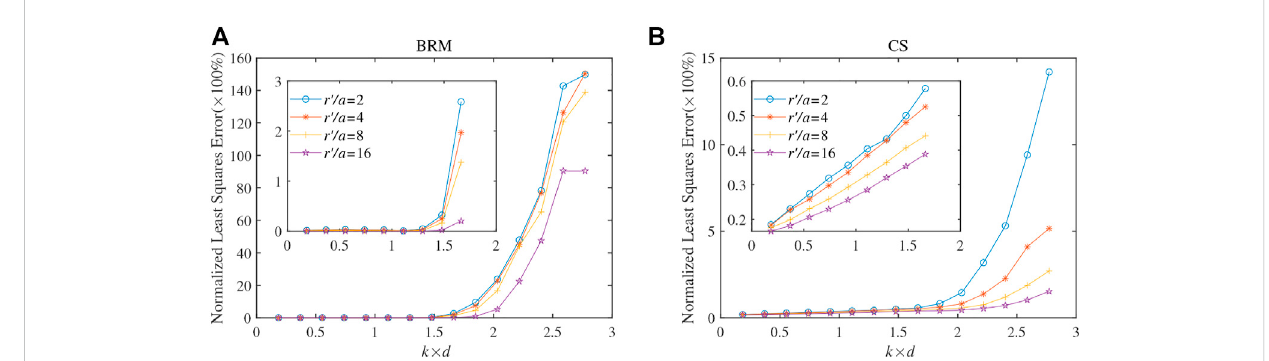
FIGURE 2 The pressure least square errors as a functon of the frequency for different radii of the envelope surfaces. The simulation results of the BRM and CS are shown in (A) and (B) , respectively.